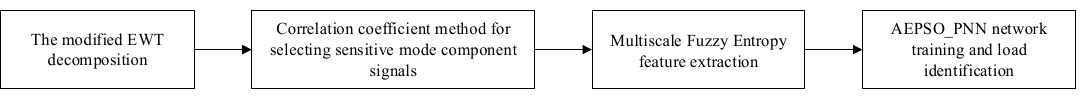
Figure 6. Algorithm flow based on the modified EWT, MFE, and AEPSO_PNN classification methods.